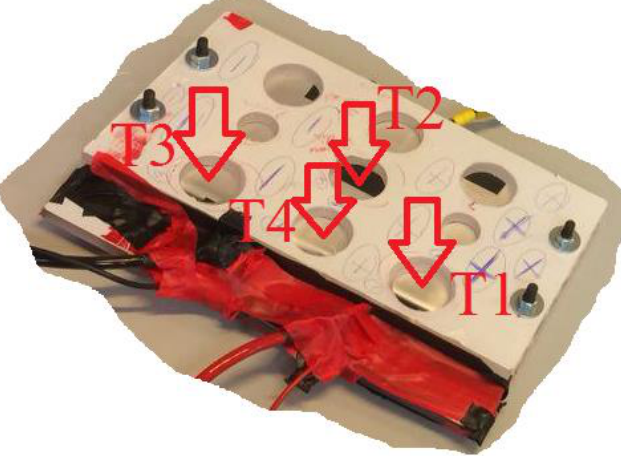
Figure 3. Locations of thermocouples on the battery cell surface.